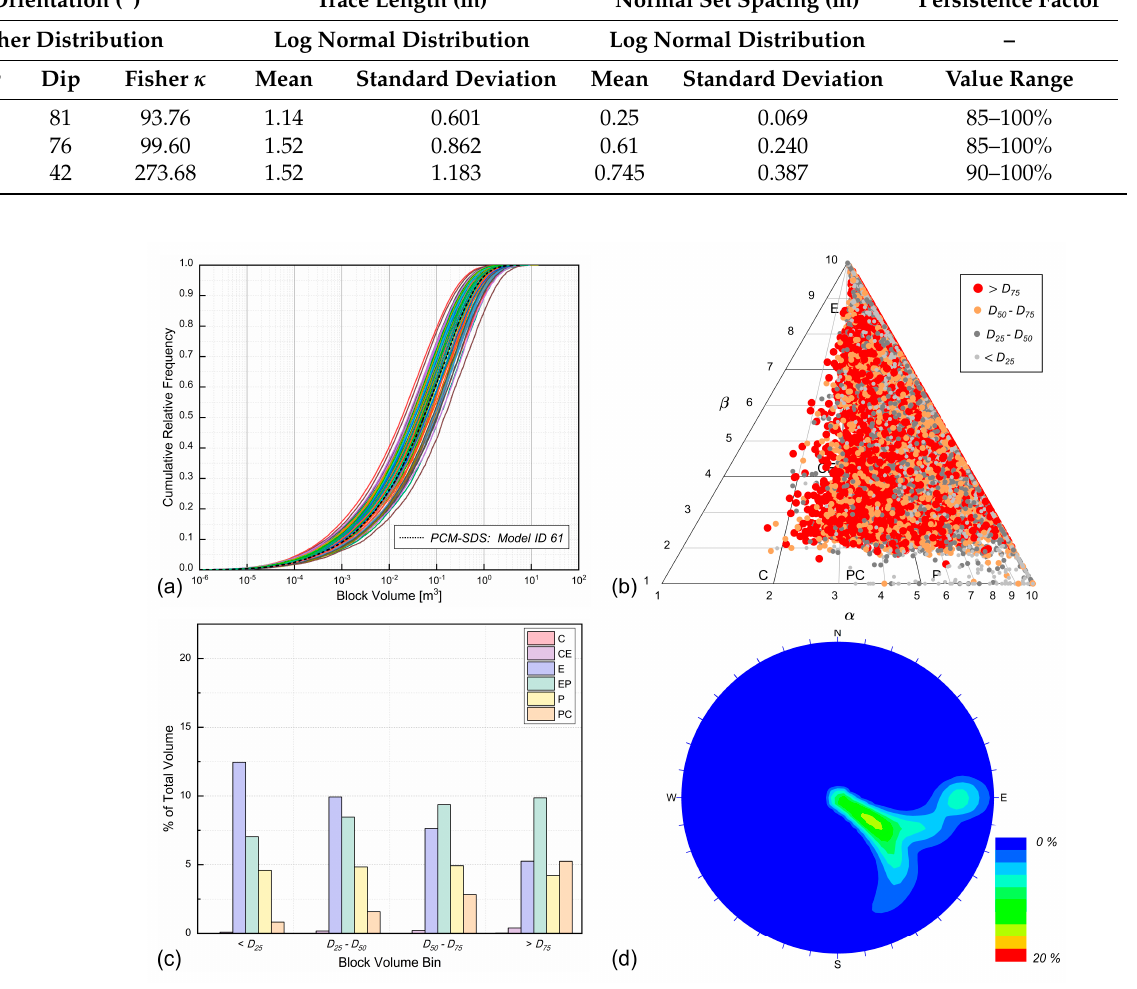
Figure 17. ( a ) The block volume distribution of IBSD S from PCM-SDS of all simulated models. ( b ) The block shape distribution from PCM-SDS. ( c ) The corresponding shape distribution with block volume ranges. ( d ) The block orientation distribution from PCM-SDS. Table 5. Summary of block characterization results of Site 2 acquired from PCM-SDS of the southern slope.